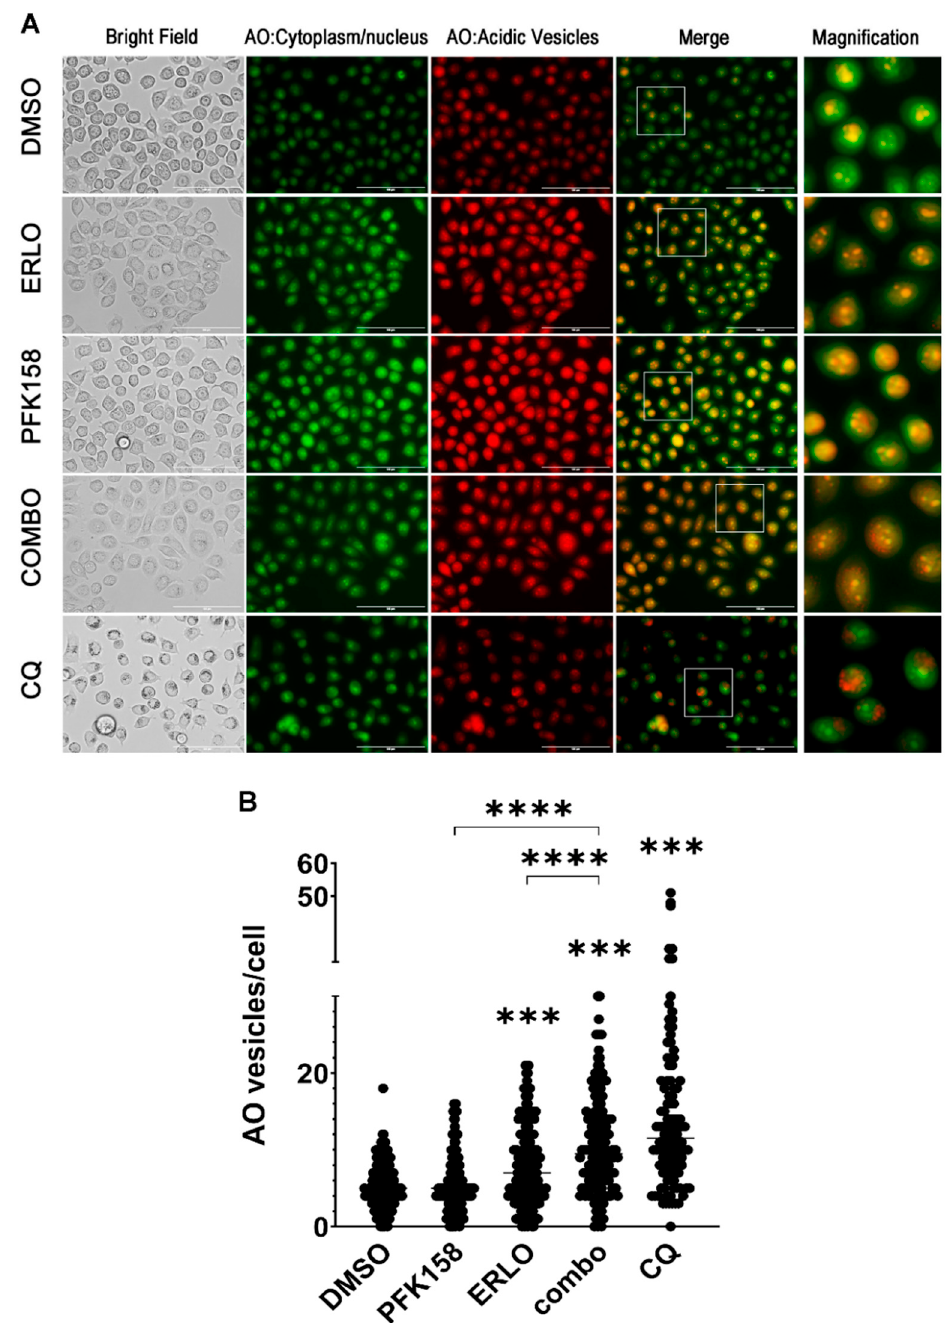
Figure 4. Dual treatment promotes the accumulation of non-released acidic vesicular organelles (AVOs) in mutEGFR PC9 cells. PC9 cells were exposed to 0.5 μ M Erlotinib and 5 μ M PFK158 alone or in combination for 48 h. Cells treated with chloroquine (CQ, 20 μ M) were used as positive control for proper AVO accumulation and labeling. AVO accumulation was evaluated by acridine orange staining. Images were taken at 20× magnification with an EVOS FL Imaging System microscope ( A ). Images are representative of three independent experiments. Bright field images illustrate cell morphology and AO accumulation in dark vesicles. Under fluorescence, acridine orange staining in the cytoplasm and nucleus fluoresce green, whereas the acidic compartments fluoresce bright red or orange-red. Scale bar: 100 µ m. The number of AO positive vesicles per cell was counted using Image J ( B ), p values are shown as follows: *** < 0.001, **** < 0.0001 (compared to DMSO or indicated treat- ment).